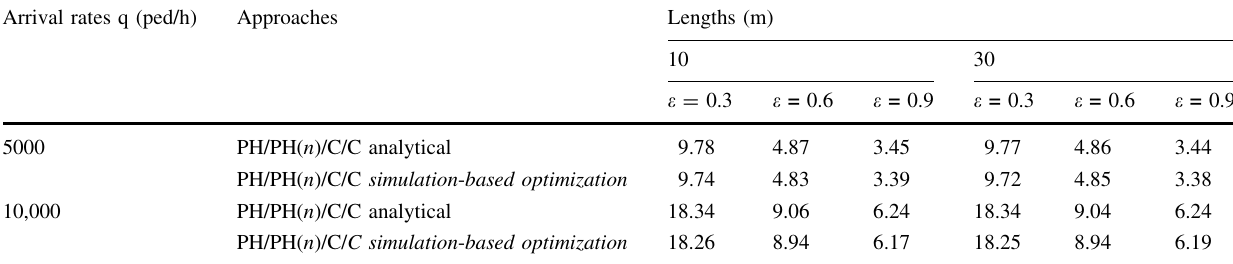
Table 3 Comparison of simulation - based optimization with analytical approach under LOS ‘B’ Arrival rates q